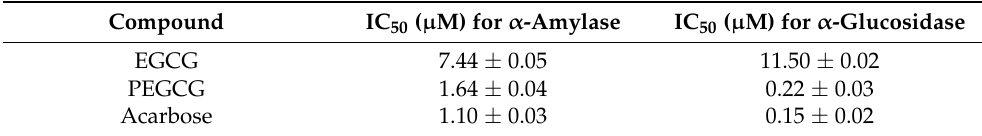
Table 5. Inhibition of α -amylase and α -glucosidase.